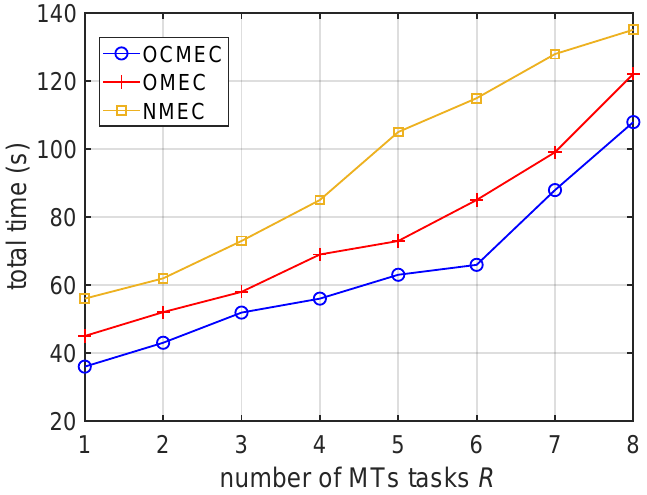
Figure 5. f gained by the 3 schemes with the increase of R